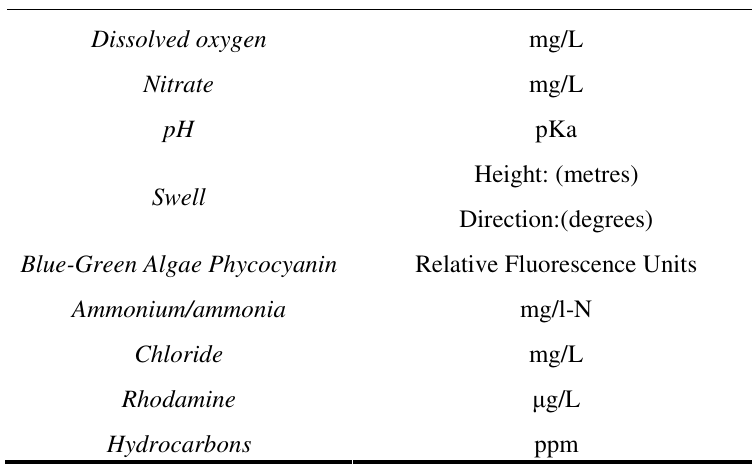
Figure 3. Examples of commercial sensors for oceanographic use (photographs reproduced with the owners’ permission): (a) EMS-SBE—16plus V2 SEACAT Temperature and conductivity (pressure optional) sensors; (b) NORTEK—Profiler Aquadopp